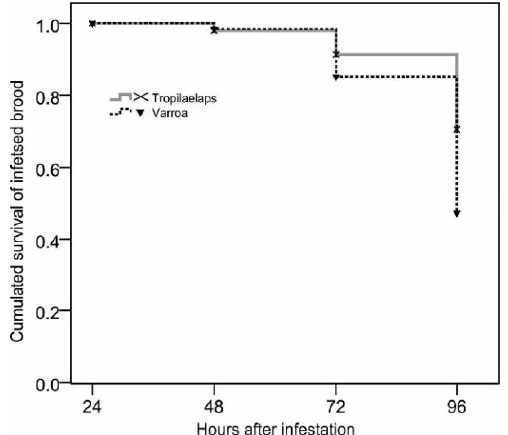
Figure 2. Survival of Tropilaelaps mercedesae - or Varroa destructor -infested brood by Apis mellifera worker bees.